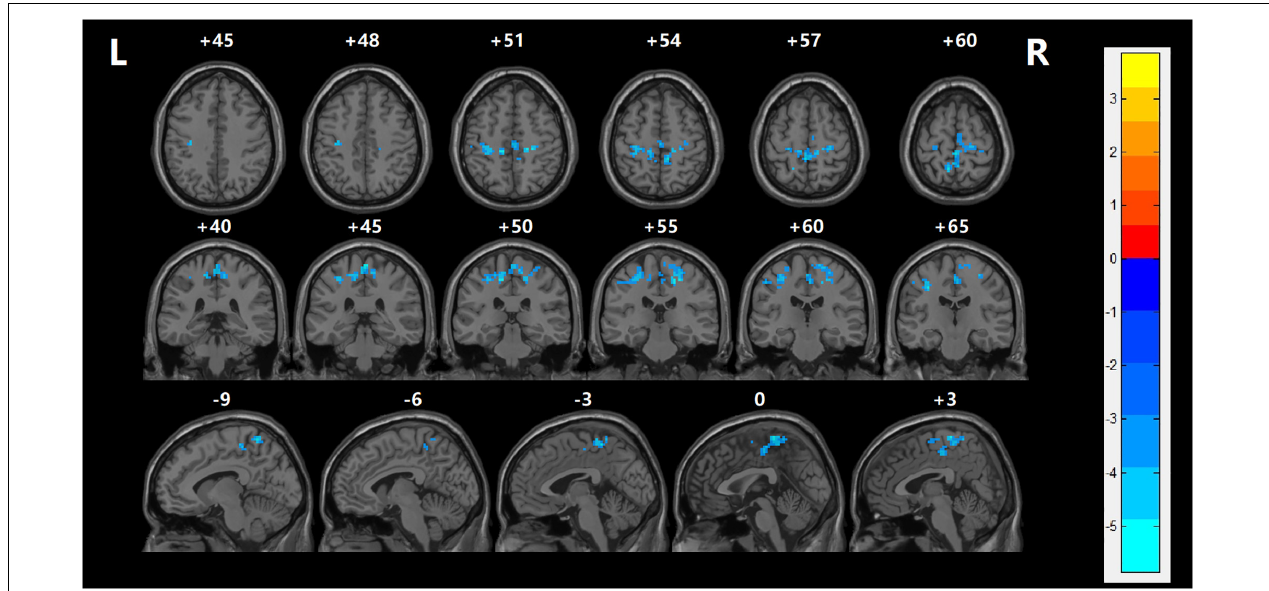
FIGURE 2 | The resting-state functional connection was analyzed between the left orbitofrontal cortex and the global brain. With regards to the HC group, left OFC had lower rsFC values in several regions including the left postcentral gyrus, left precuneus, left superior temporal gyrus, and left precentral gyrus with FES (TECE corrected, voxel-level, p < 0.001; cluster level, p < 0.05). The cool color indicates that rsFC is decreased in the naïve patients with FES. Reversely, warm color indicates rsFC is higher than in the healthy control group.